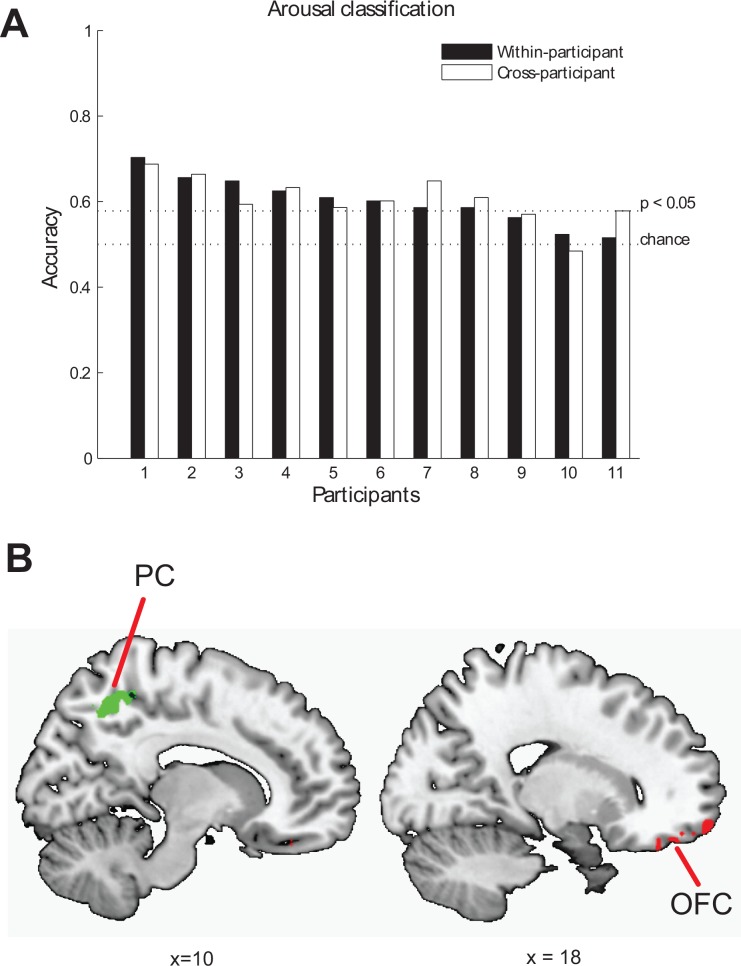
MVPA results for arousal.(A) Classification accuracies for within-participant (filled bars) and across-participants (unfilled bars) arousal identification. (B) Two clusters, the right anterior part of orbitofrontal cortex (OFC) and the right precuneus (PC) are shown on sagittal slices.